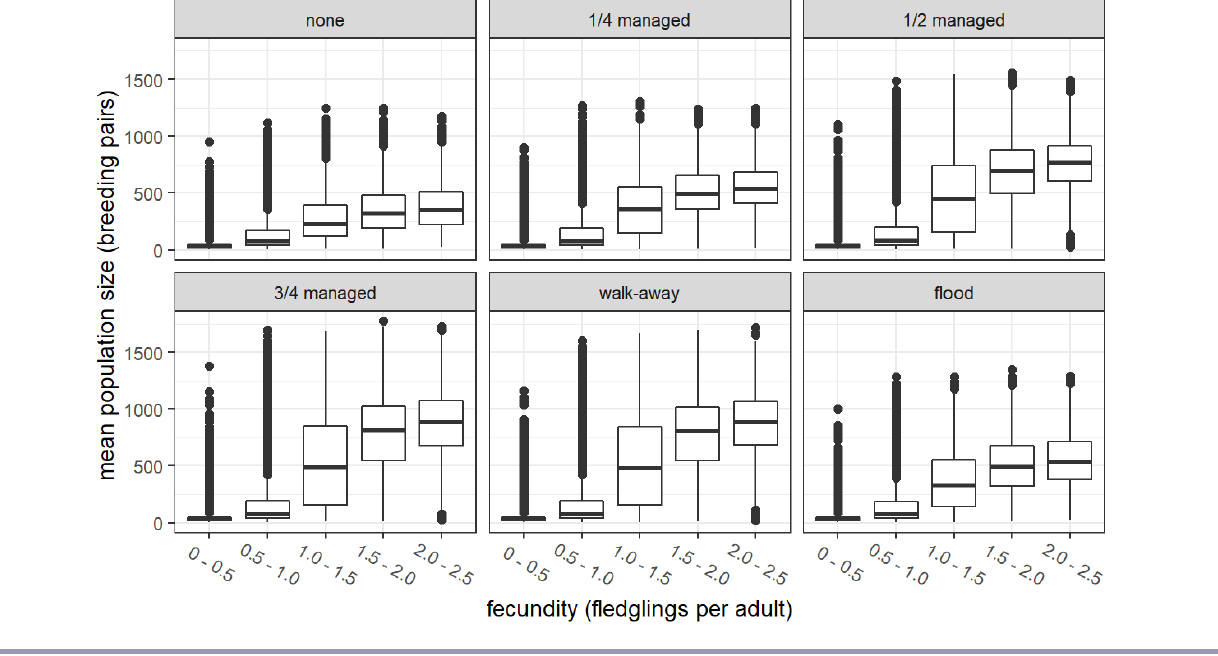
Fig. 5 . Mean number of breeding pairs over the duration of the simulation. Results are summarized under the full range of parameter uncertainty for six potential habitat management scenarios. Results are grouped by fecundity ranges achieved after simulated impact from Brown-headed Cowbird brood parasitism.